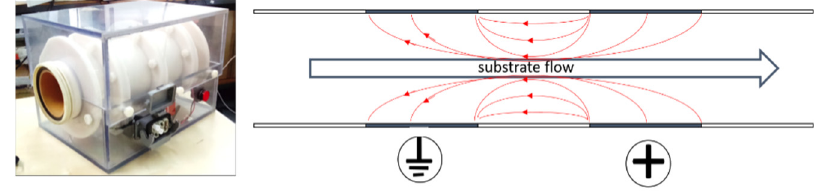
Figure 2. PEF tubular prototype apparatus, and scheme of working principle .